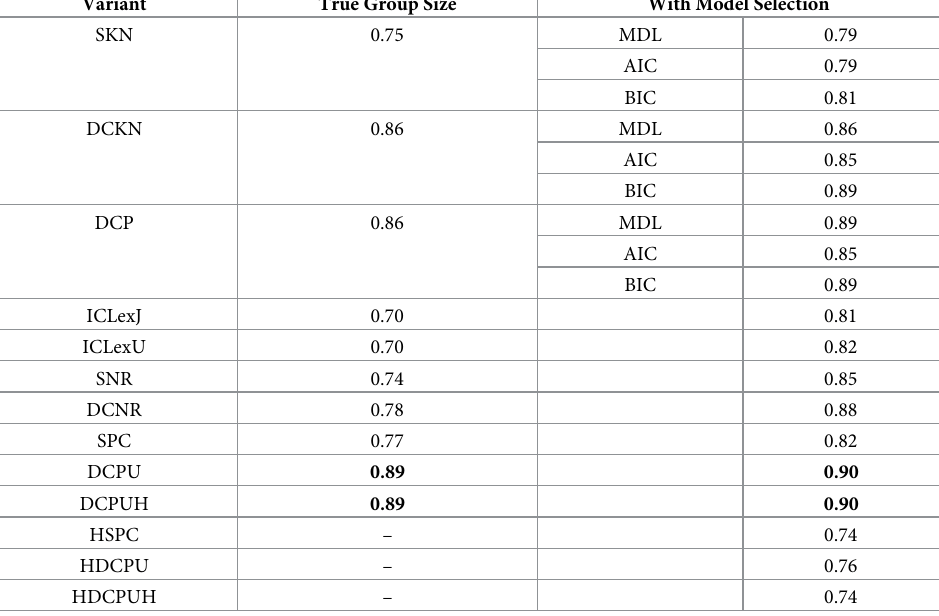
Table 3. Normalized AUMIC of the different SBM variants of the LFR benchmark for 0 � μ t � 0.5 based on 10 executions of the MHA 250 000 from 10 random partitions for each number of groups K = 1, ... , 30 and each μ t = 0, 0.1, ... ,